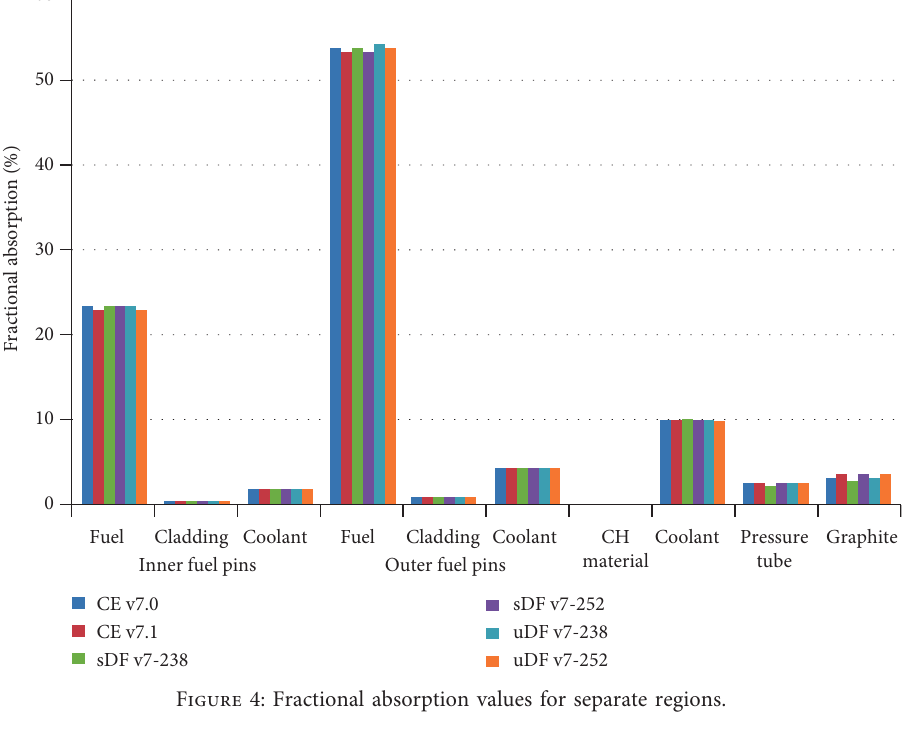
Figure 4: Fractional absorption values for separate regions.